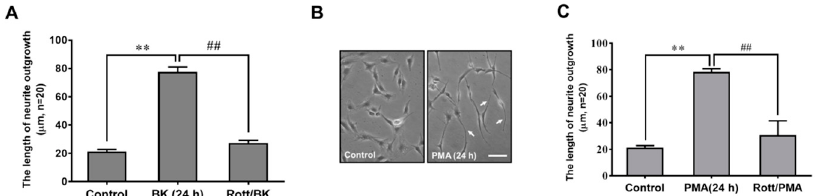
Figure 3. Involvement of PKC- δ in BK-induced RBA morphological change into neuron-like cells. ( A ) RBA cells were pretreated with rottlerin (1 µ M) for 1 h and then incubated with or without BK (10 nM) for 24 h. ( B ) Cells were treated without (control) or with PMA (1 µ M) for 24 h. ( C ) Cells were pretreated with rottlerin (10 µ M) for 1 h before exposure to 1 µ M PMA for 24 h. The phase-contrast images were obtained (( B ), scale bar = 20 µ m) and the length of neurite fiber outgrowth at 24 h was quantified ( A , C ). The image represents one of at least three individual experiments ( B ). Data are expressed as the mean ± SEM of at least three independent experiments. ** p < 0.01, as compared with control. ## p < 0.01, as compared with BK or PMA